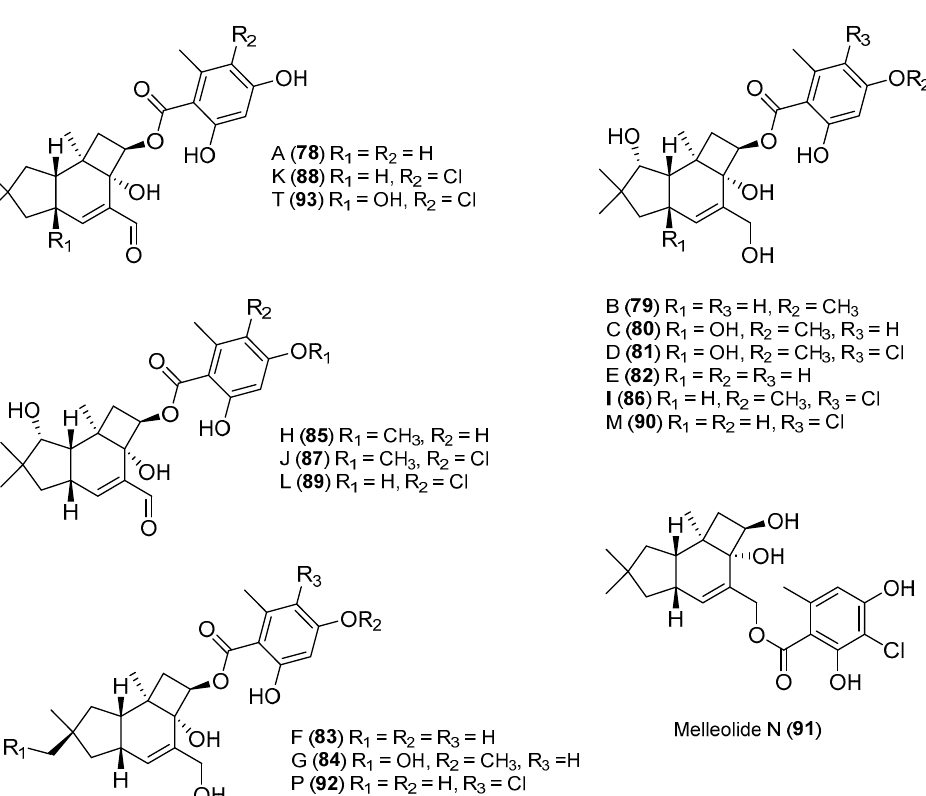
Figure 15. Structures of melleolides 78 – 93 from the Armillaria genus of fungi.